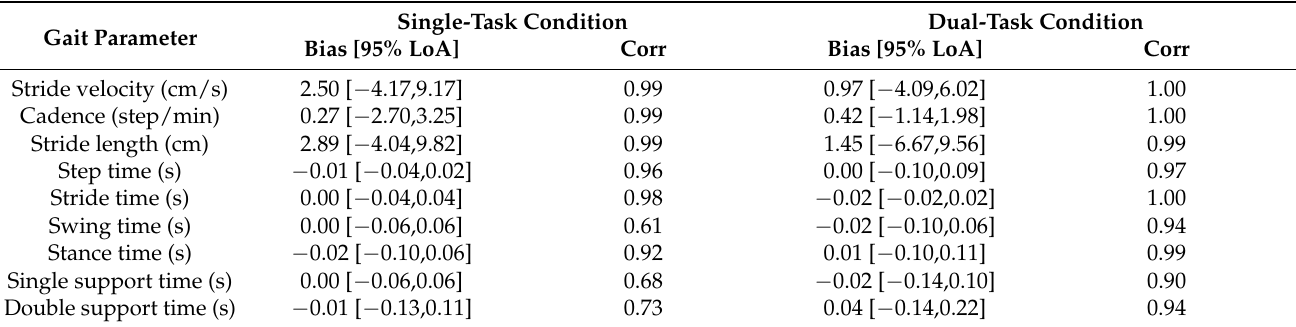
Table 4. Concurrent validity of pressure-sensing insoles and reference electronic walkway during single-task and dual-task conditions in the mean stride data analysis.